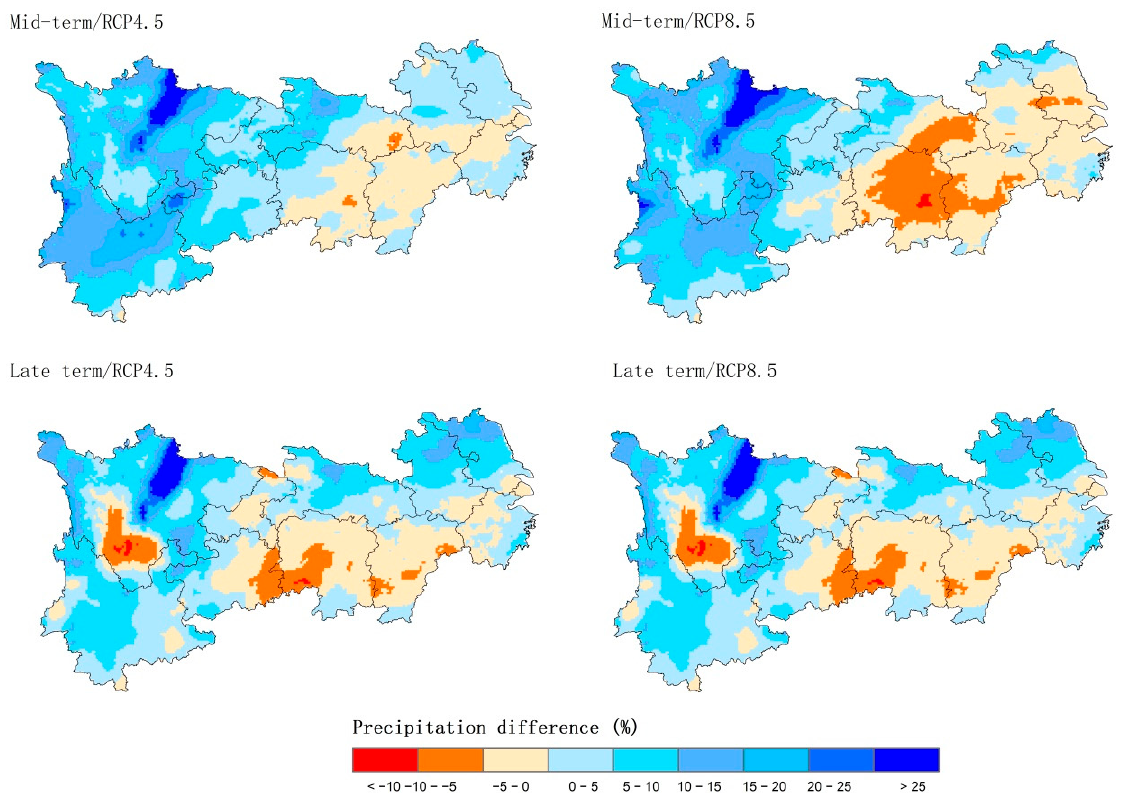
Figure 10. Spatial pattern of annual mean precipitation changes in the mid-term and late-term 21st century relative to the reference period under the RCP4.5 and RCP8.5 scenarios in the YREB.